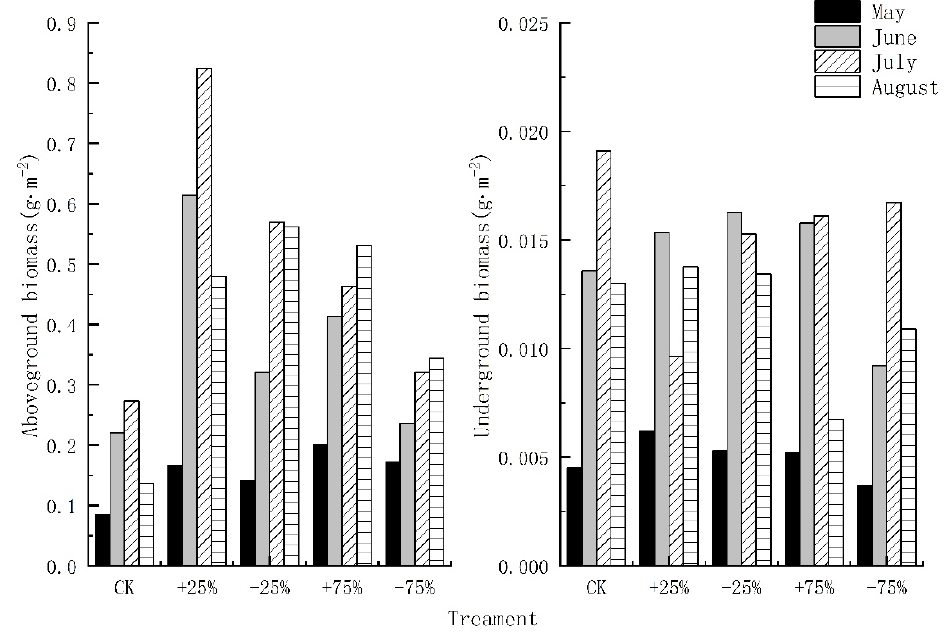
Figure 5. The aboveground and underground biomass changes during the growing season of the Niaodao Lakeside wetland.